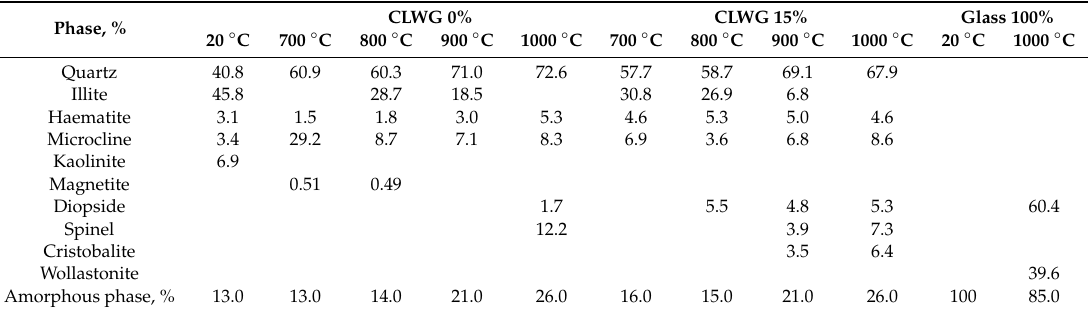
Table 2. The phase composition of the fired clay and clay-glass